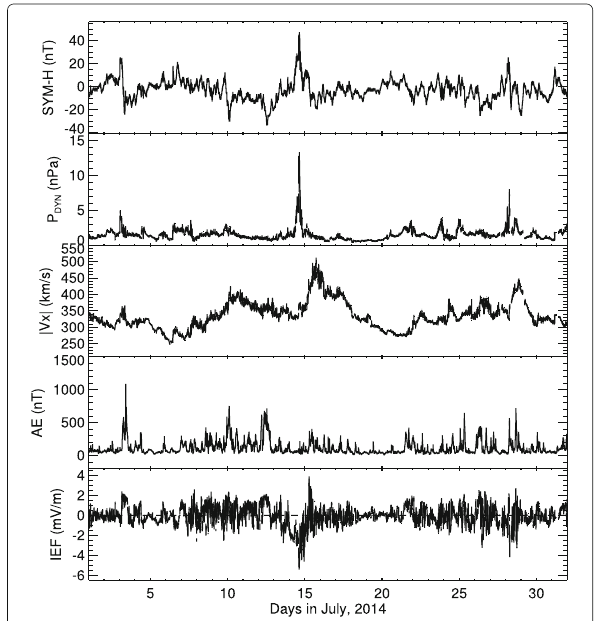
Fig. 7 Overview of solar wind and geomagnetic activity throughout the month of July 2014. The top panel shows the SYM-H index, the second panel shows the solar wind dynamic pressure, the third shows the solar wind speed, the fourth panel shows the AE index, and the fifth shows the interplanetary electric field (IEF). Note that the solar wind dynamic pressure and the IEF have been propagated in time to the magnetopause location